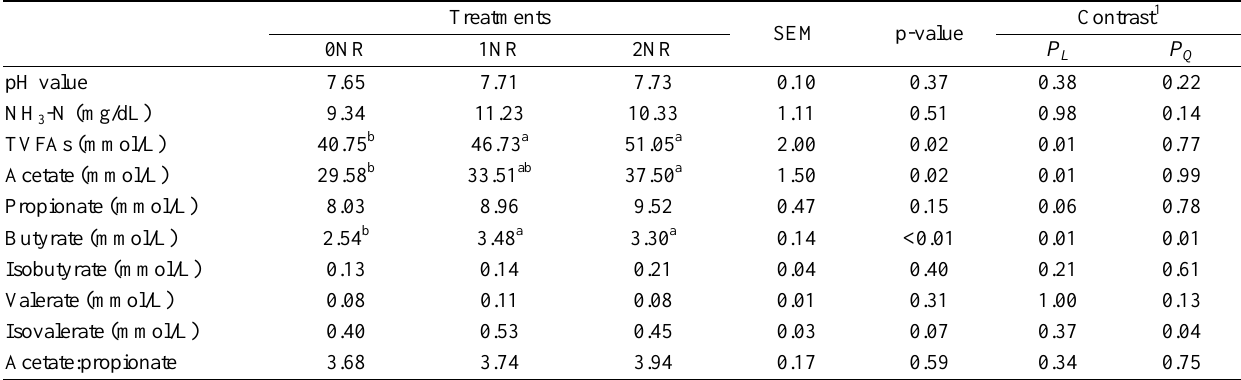
Table 1. Effects of nitrate on ruminal fermentation parameters in nitrate- adapted steers Treatments